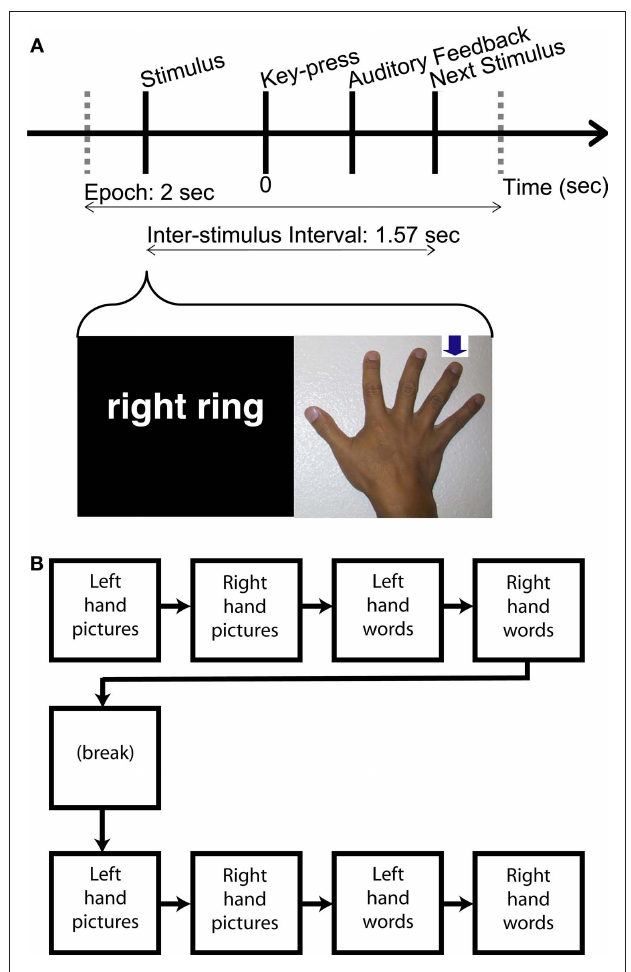
FIGurE 1 | Schematic of visually cued finger movement task. (A) One of 20 stimuli indicating which finger to move is presented to the patient. Half of the stimuli are words naming a finger, and the other half are pictures of a hand with an arrow pointing to a finger. Stimuli are spaced 1.57 s apart. For trial-average spectral changes computed in this study, the data were parsed into 2-s epochs centered on the key-press. (ICA was performed on the continuous data before epoching.) Patients are presented with an audio tone indicating whether their performance on a given trial was correct or incorrect. (B) The study was a block design, with a block for each hand and stimulus type. The presentation of finger stimuli was randomized within a block. The entire experimental task was run twice for Patients 1,2,3 and once for Patient